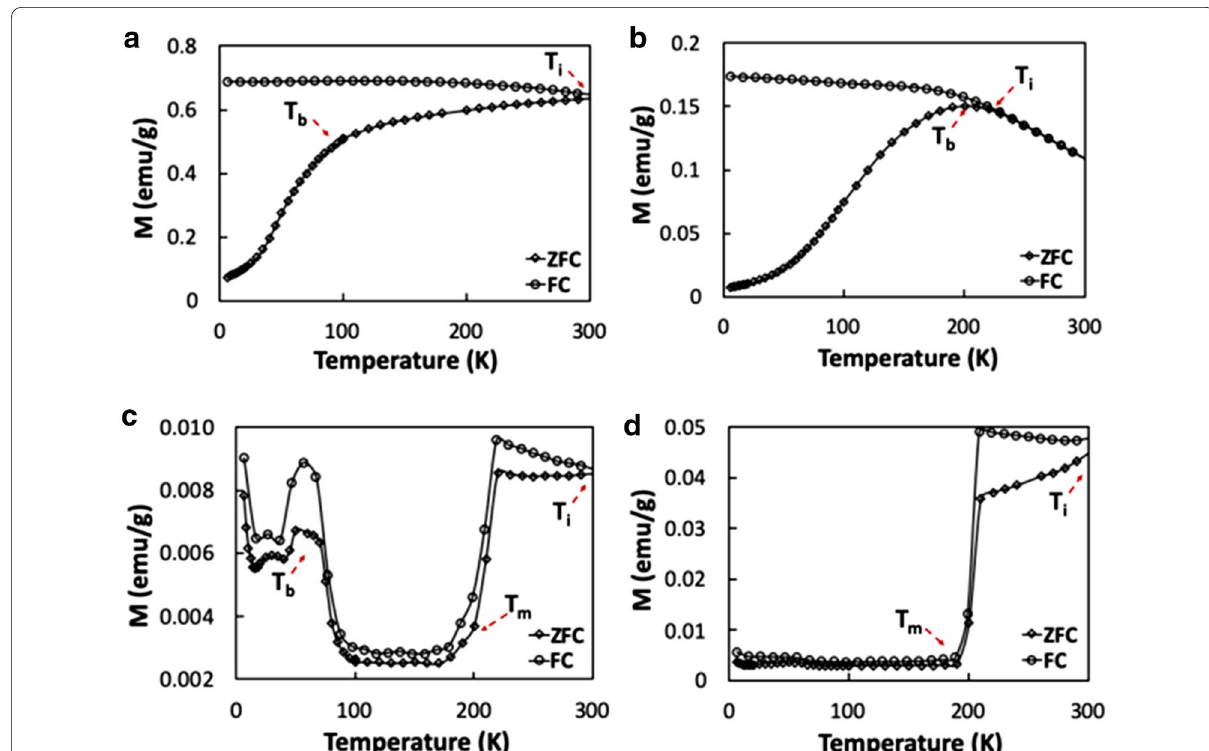
Fig. 4 ZFC and FC curves at 100 Oe from 6 to 300 K displaying the Blocking Temperature (T b ), Irreversibility Temperature (T i ), and the Morin Temperature (T m ) for the: a nanorods, b nanosheets, c nanodiamonds, d nanospheres